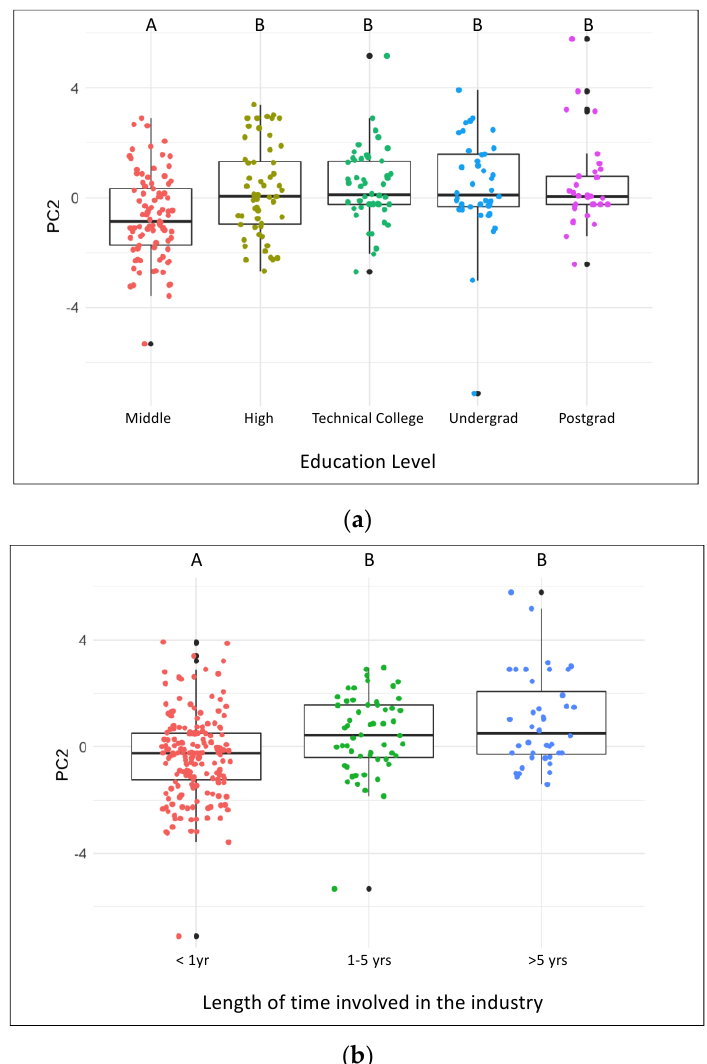
Figure 5. Boxplots of PC2 loadings of attitudinal items for respondents with different education levels ( a ) and length of time involved in the industry ( b ). Uppercase letters indicate differences between groups (groups with different letters are significantly different p < 0.05 from each other).